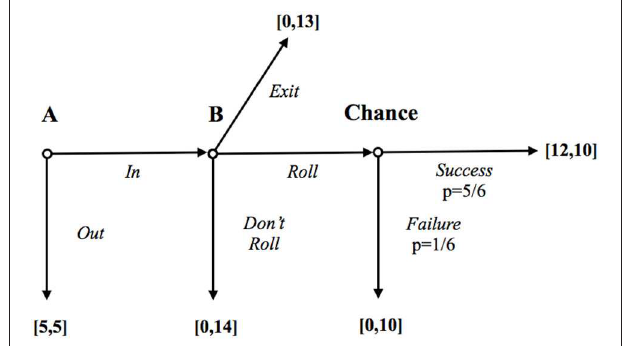
FIGURE 2 | Trust game with exposure and a costly exit